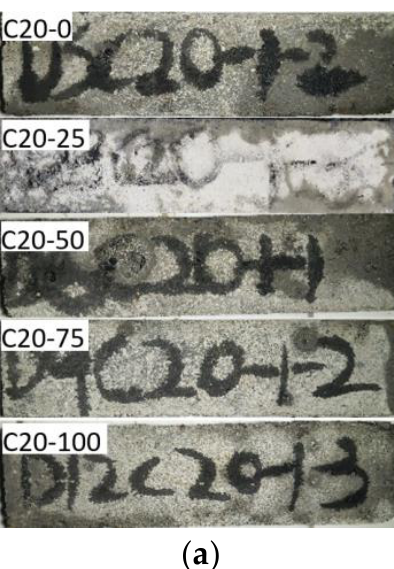
Figure 17. C20 concrete picture with different freeze–thaw cycles.( a ): Freeze–thaw cycles 0 time; ( b ): Freeze–thaw cycles 100 times.